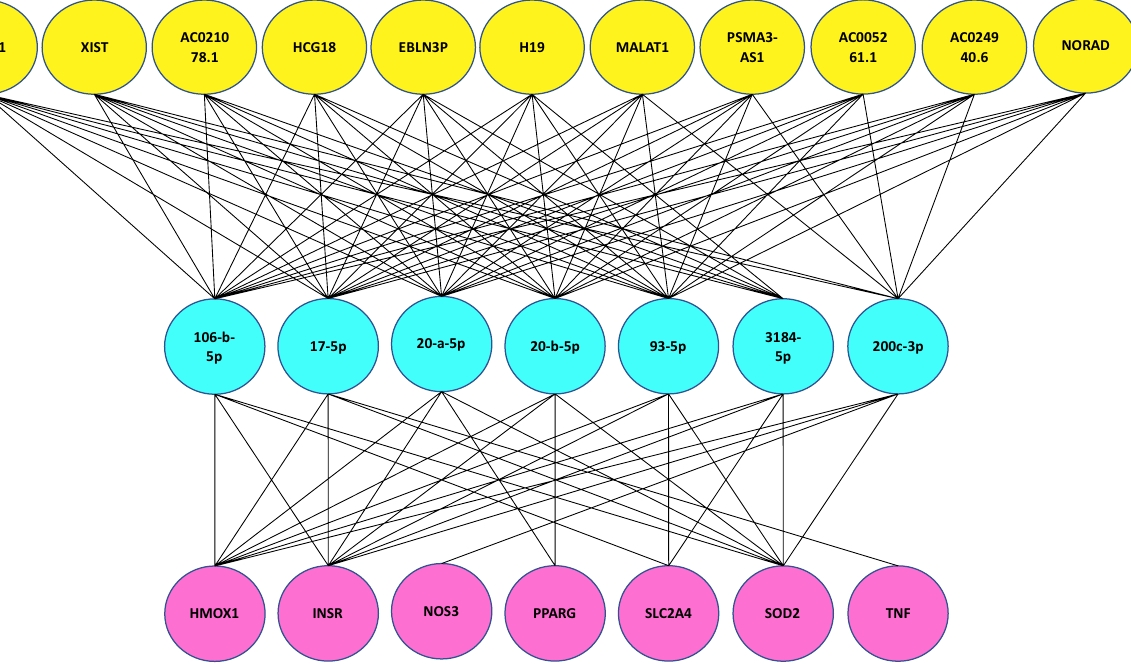
Figure 2. Final mRNA-miRNA-lncRNA network. The first layer (purple nodes) consists of 7 shared mRNAs between DM and AD that were extracted from curated Disgenet database. The second layer (blue nodes) consists of 7 high degree miRNAs obtained from mRNA-miRNA bipartite network and the last layer (yellow nodes) consists of 11 high degree lncRNAs achieved from miRNA-lncRNA bipartite network.